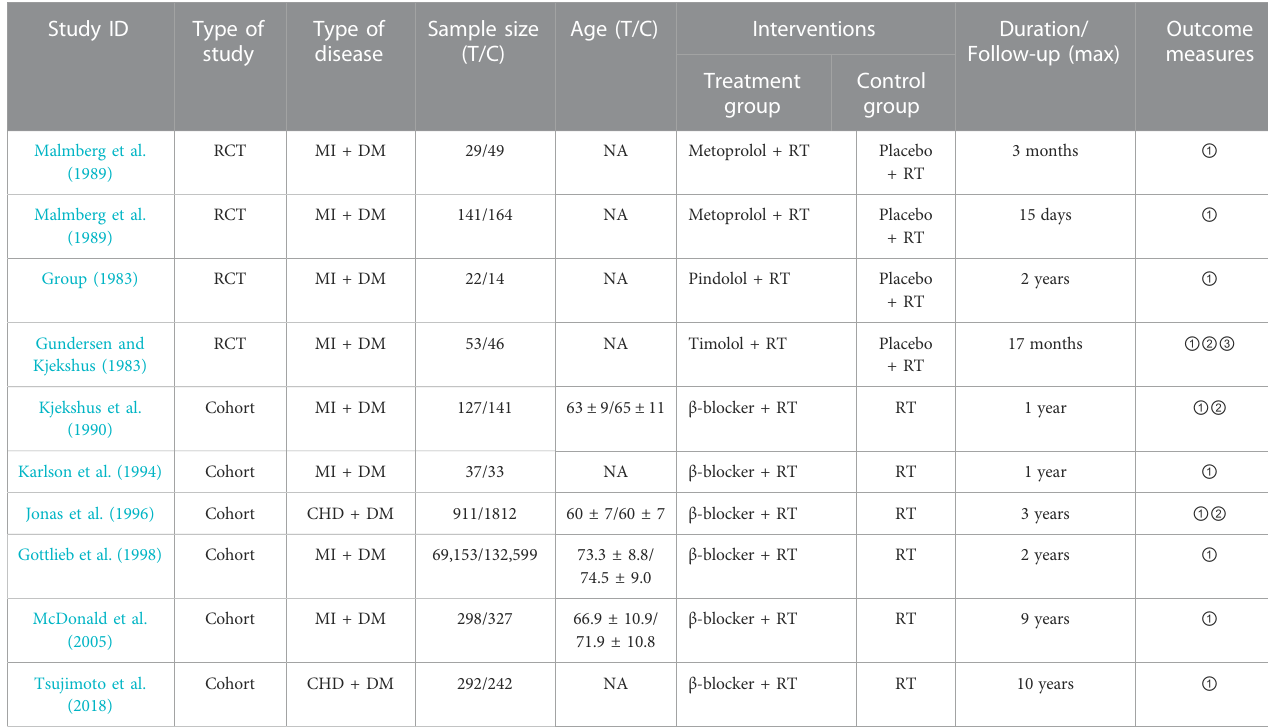
TABLE 2 Characteristics of the included studies.